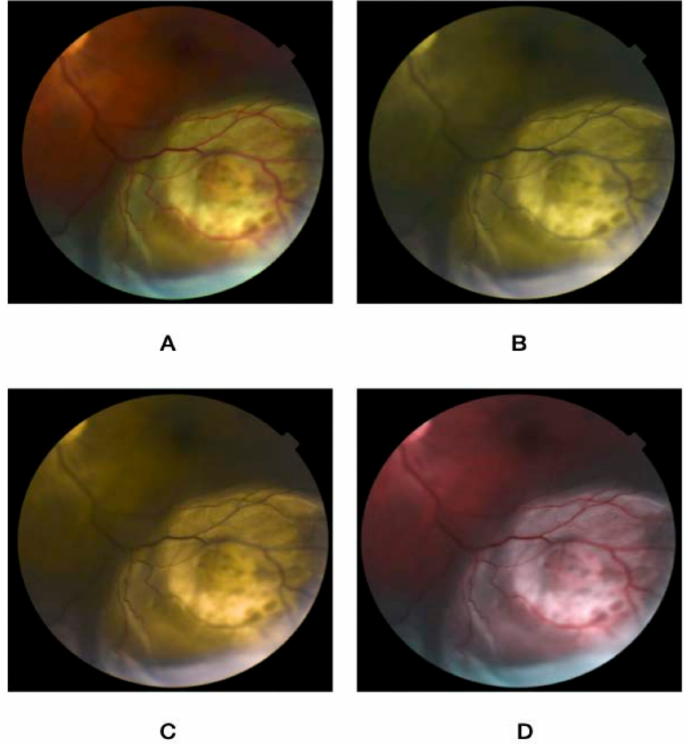
Figure 4. Fundus images for malignant melanoma ( A ), under simulated protanopia ( B ), deuteranopia ( C ), and tritanopia ( D